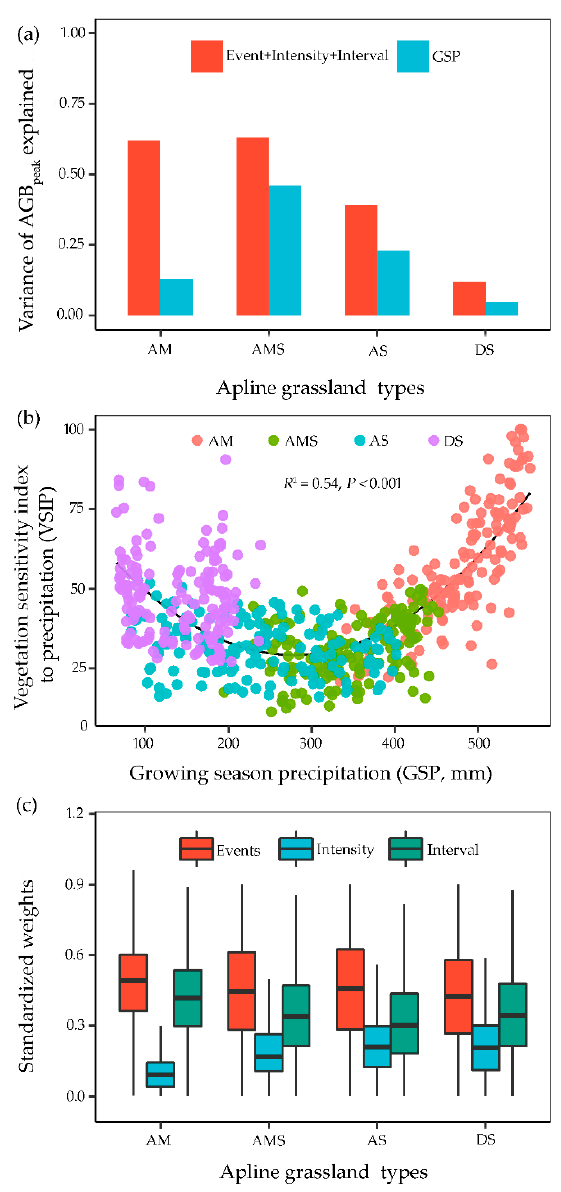
Figure 7. Relative contribution of the number and intensity of precipitation events and the time interval between precipitation events to the vegetation sensitivity index of alpine grassland on the northern Tibetan Plateau. ( a ) The variance in peak aboveground biomass (AGB peak ) explained at the four observation sites. ( b ) The relationship between the vegetation sensitivity index and growing season precipitation. ( c ) The standardized weights of the number of precipitation events, intensity of precipitation events, and time interval between precipitation events for alpine meadow (AM), alpine meadow steppe (AMS), alpine steppe (AS), and desert steppe (DS), respectively.